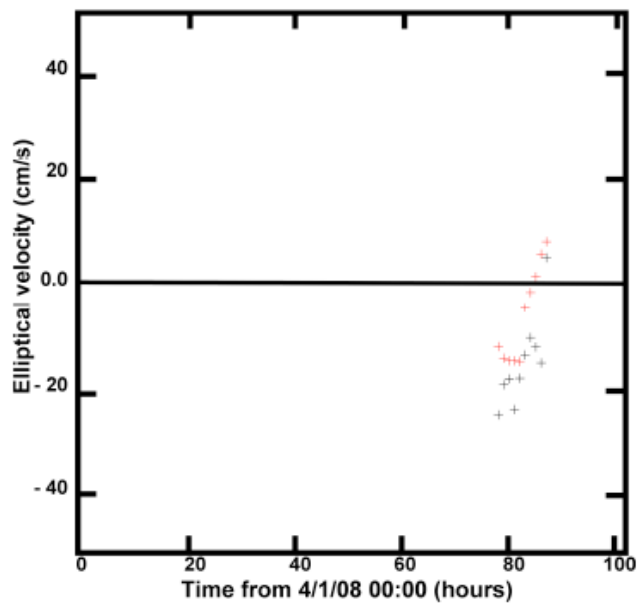
Figure 13. Time series of elliptical velocities measured at the point shown in Figure 12 by COMM (Black) and Drifter